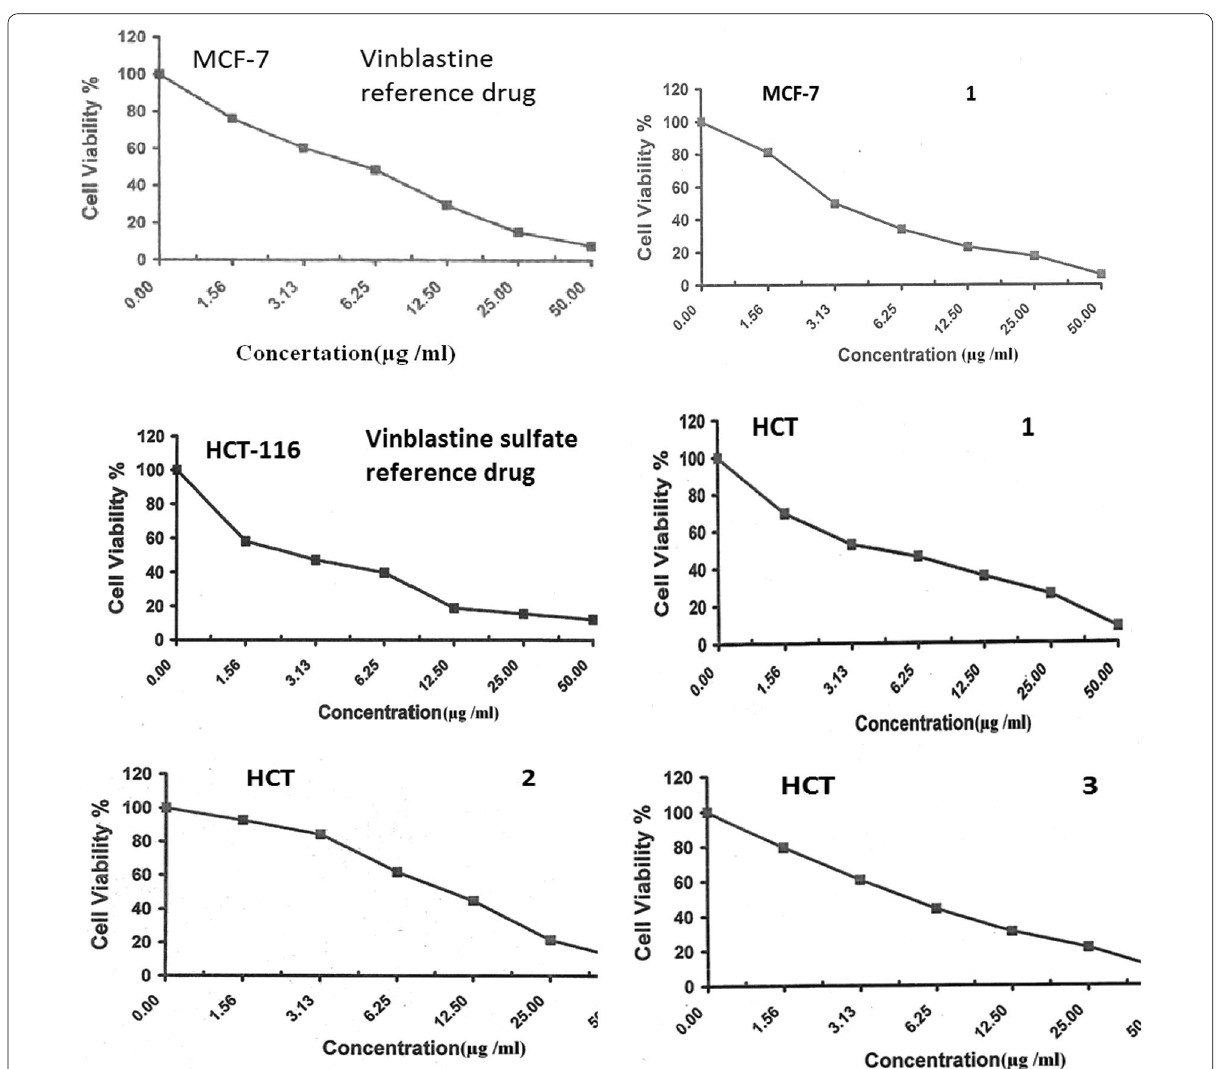
Fig. 4 Viability values of quinazoline derivatives 1 – 3 and Vinblastine sulfate against HCT‑116 cell line